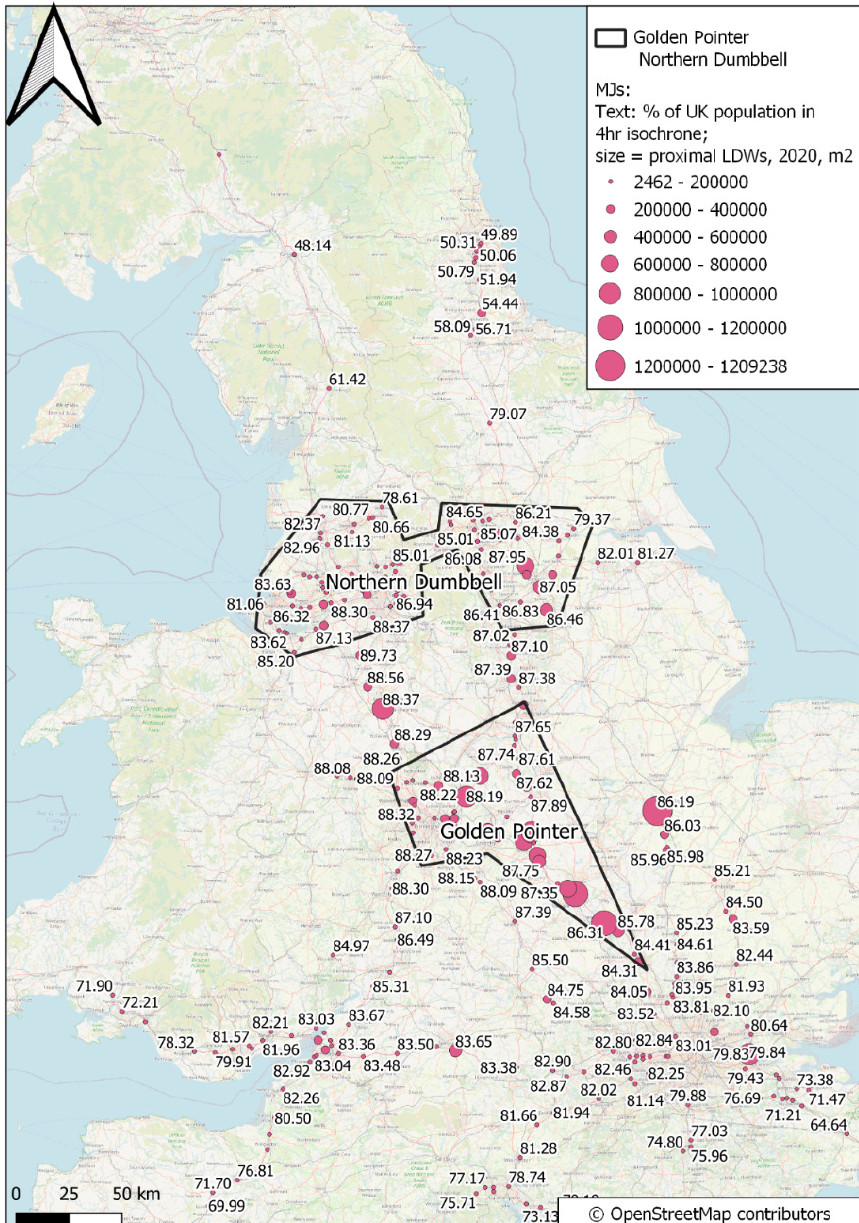
Figure 5. Junctions with proximal LDW development (2020) and isochrone population as a percentage of total UK popula‐ tion,